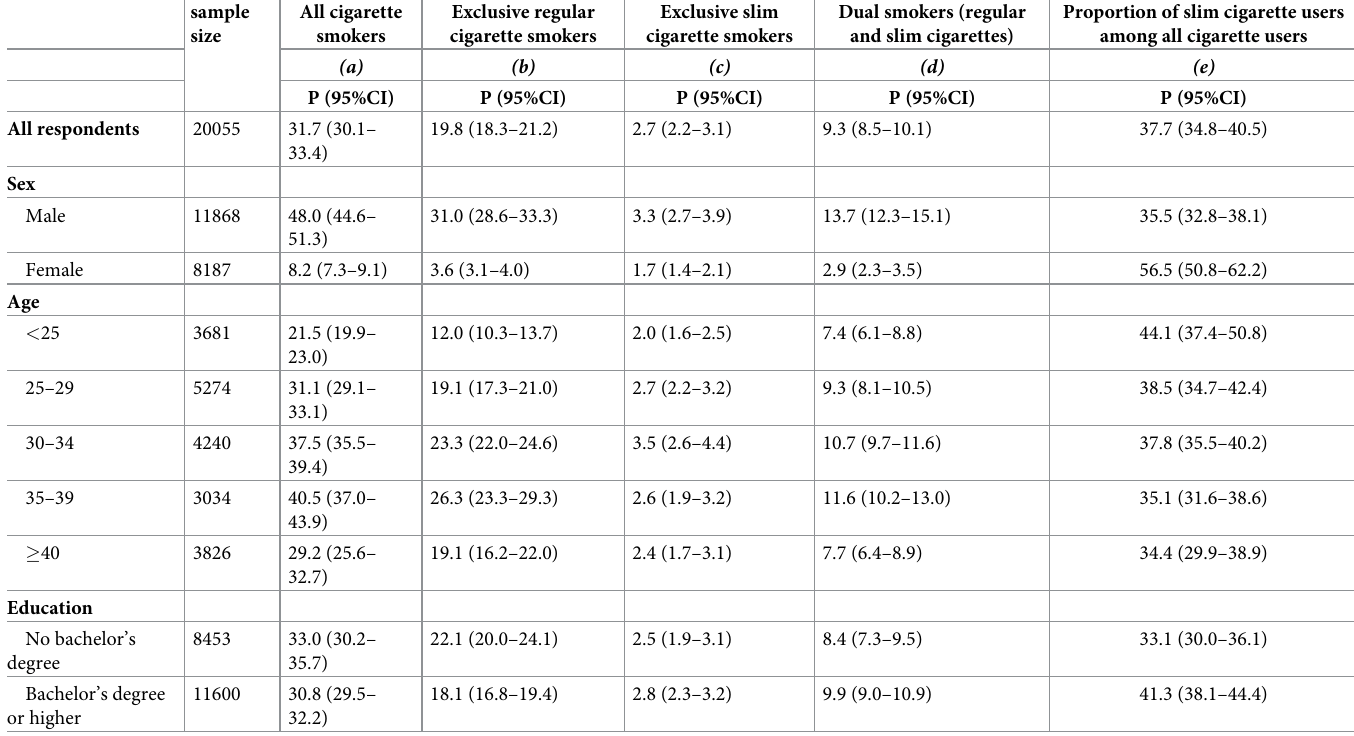
Table 1. Percentages of current regular cigarette and slim cigarette smokers and proportion of slim cigarette smokers among all